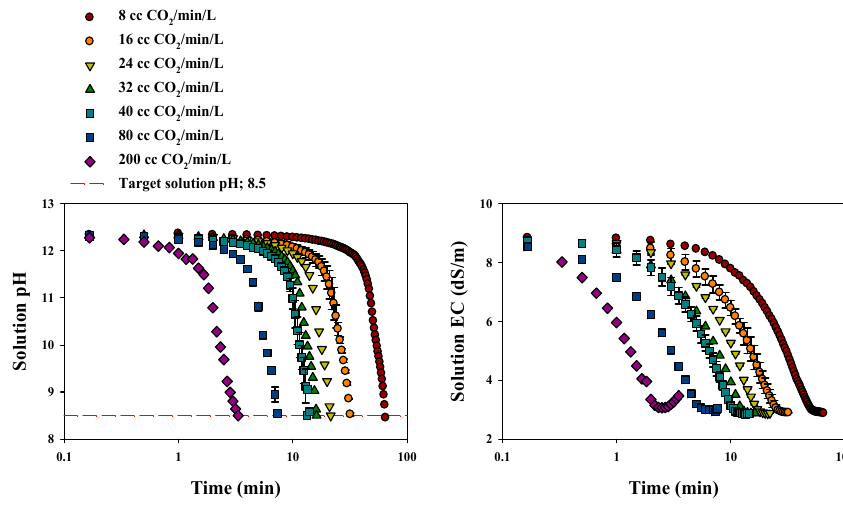
Figure 5. Changes in solution pH and EC during the carbon mineralization processes.